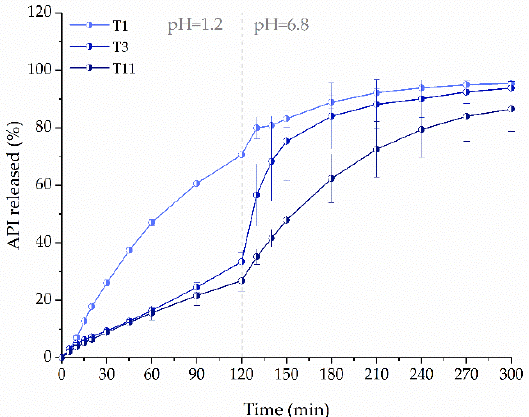
Figure 10. The influence of drug loading in filaments on dissolution profiles of ketoprofen from 3DP tablets (infill density equal to 35%, dosage 75 mg).